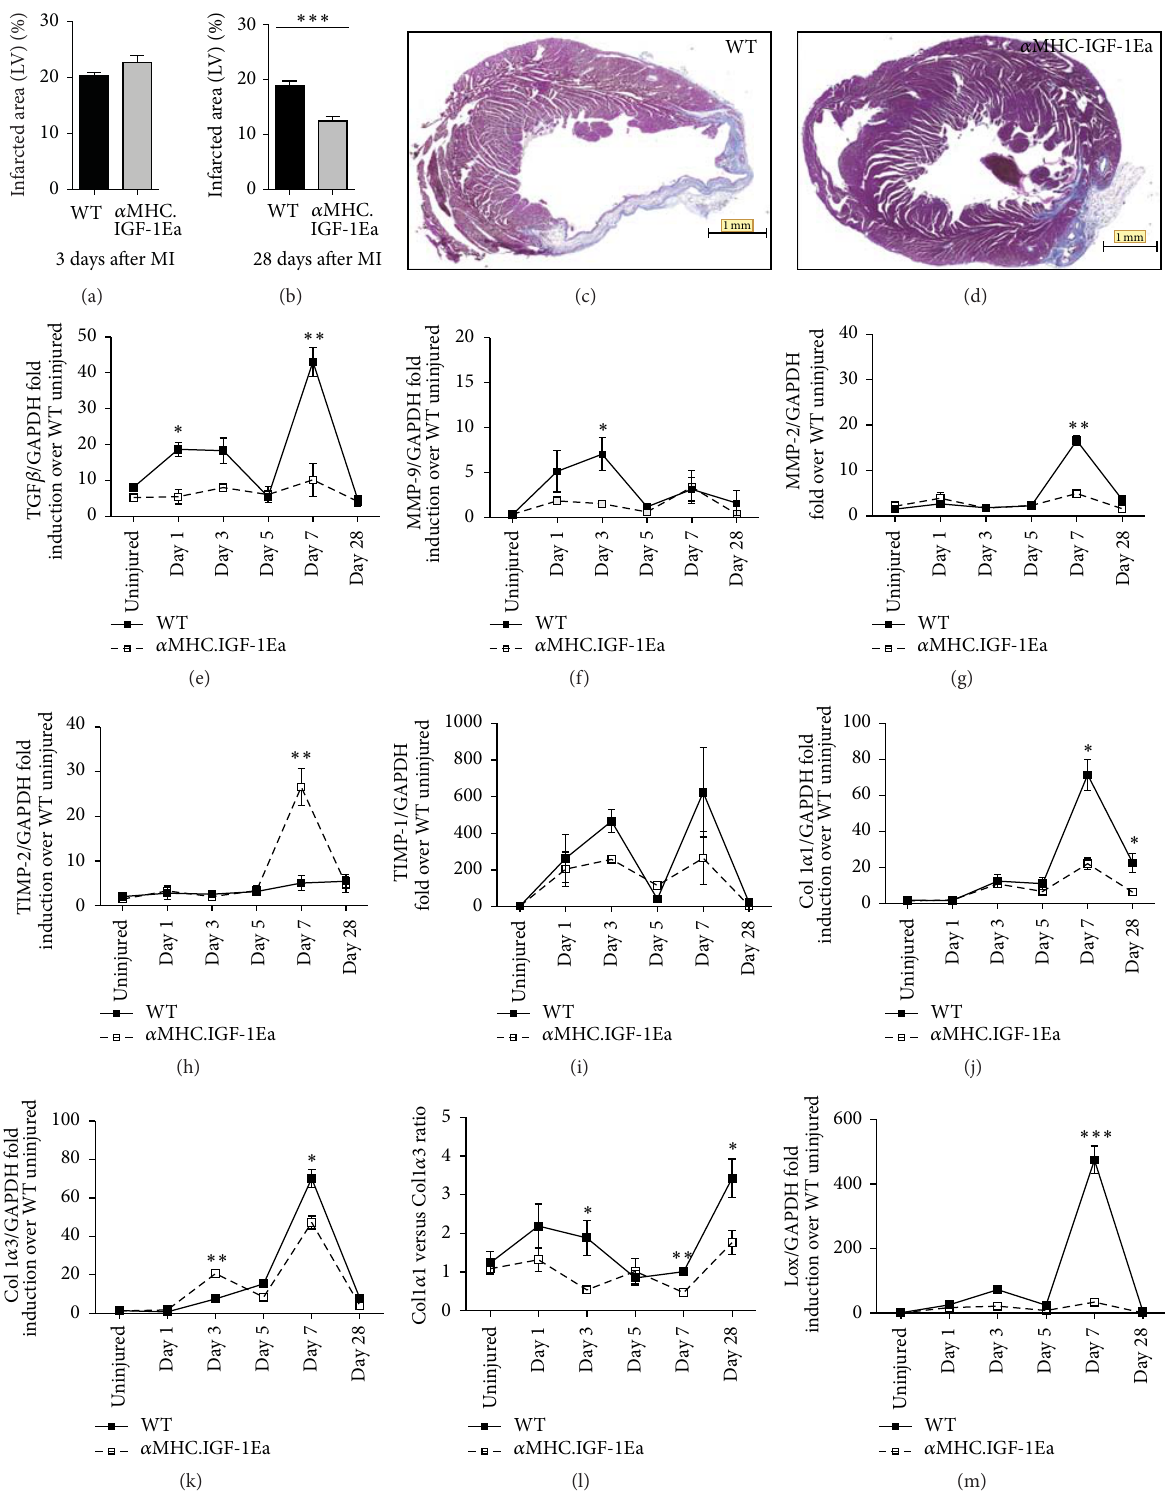
Figure 2: Positive remodeling in the 𝛼 MHC.IGF-1Ea infarcted region after myocardial infarction. Quantification of the infarcted area at (a) 3 days and (b) 28 days after MI. 𝑛 = 3 . Representative histological sections of (c) WT and (d) 𝛼 MHC.IGF-1Ea hearts stained with Masson’s trichrome 28 days after MI. Scale bar: 1 mm. ((e)–(l)) mRNA relative expression of (e) transforming growth factor beta (TGF- 𝛽 ), (f) matrix metalloproteinase 9 (MMP-9), (g) matrix metalloproteinase 2 (MMP-2), (h) tissue inhibitor of metalloproteinase (TIMP) 2, (i) TIMP-1, (j) collagen (Col) I 𝛼 1, (k) Col I 𝛼 3, (l) ColI 𝛼 1/ColI 𝛼 3 ratio, (m) lysyl oxidase in the infarct area. Results are expressed as mean fold induction ± SEM. Solid lines represent WT mice. Dashed lines represent 𝛼 MHC.IGF-1Ea mice. 𝑛 = 3 per group. Two-tailed Student’s t -test was performed to compare WT versus 𝛼 MHC.IGF-1Ea at selected time points after MI. ∗ 𝑃 < 0.05 , ∗∗ 𝑃 < 0.005 , ∗∗∗ 𝑃 < 0.001